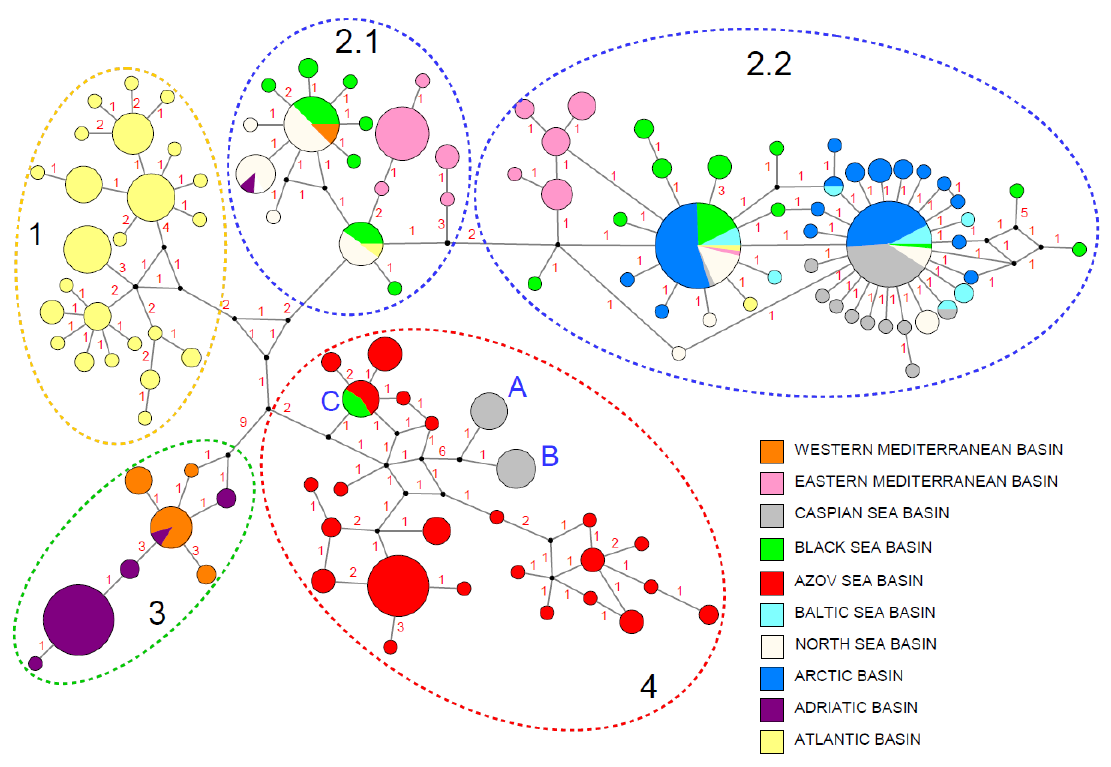
Figure 2. Median-joining haplotype network of the COI sequences of A. anatina dataset ( N = 500; the list of sequences is presented in Table S1). The black numbers indicate genetic lineages, which were used as separate samples in population genetic analyses: 1. lineage IBER ( N = 68 sequences); 2.1. sub-lineage EUR1 ( N = 64 sequences); 2.2. sub-lineage EUR2 ( N = 241 sequences); 3. lineage ITAL ( N = 47 sequences); 4. lineage AZOV ( N = 80 sequences). Blue letters indicate the haplotypes: A —Kura River basin, B —Southern Caspian basin, C —Baranovskoe Lake. The red numbers near branches indicate the number of nucleotide substitutions between haplotypes. The size of the circles corre- sponds to the number of available sequences for each haplotype (smallest circle = 1 sequence).